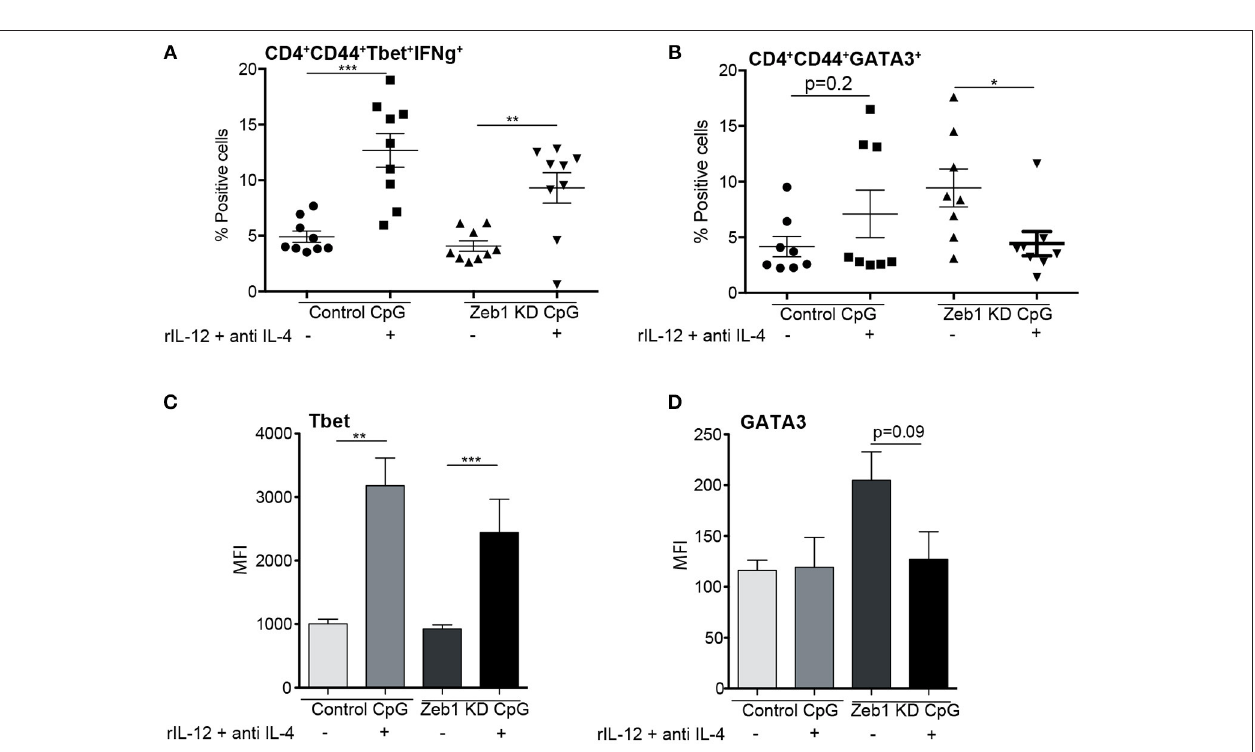
FIGURE 8 | Decreased IL-12 secreted by Zeb1 KD cDC1 DCs is responsible for inducing Th2 differentiation n = 8–10. (A) Scatter-plot depicting an increase in percentage positive cells for Th1 markers Tbet + IFN γ + in Zeb1 KD DCs upon supplementation of recombinant IL-12 and anti-IL4 cytokine in the culture media during DC -T cell co-culture n = 8–10. (B) Scatter-plot depicting a significant decrease in percentage positive cells for Th2 marker GATA3 + in Zeb1 KD DCs upon addition of recombinant IL-12 cytokine and anti-IL4 in the culture media during DC-T cell co-culture n = 8–10. (C) Bar-plot representing the MFI for Th1 marker Tbet + in Zeb1 KD DCs upon supplementation of rIL12 and anti-IL4 cytokine in the culture media during DC -T cell co-culture n = 8–10. (D) Bar-plot representing the MFI for Th2 marker GATA3 + in Zeb1 KD DCs upon supplementation of rIL12 and anti-IL4 cytokine in the culture media during DC -T cell co-culture n = 8–10. p -values